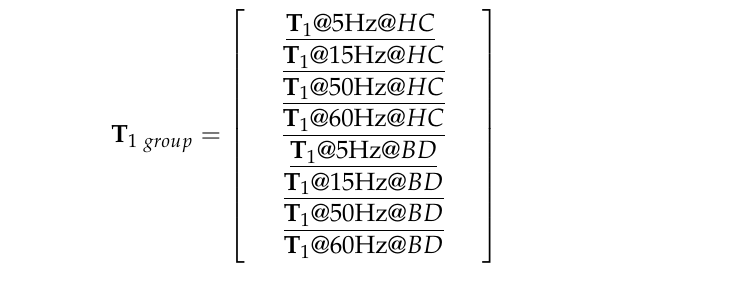
Table 3. Representation of the grouping of the feature matrices computed by means of analyzing the vibration signals in TD, FD and TFD for each supply frequency for the considered bearing conditions; where the notations HC and BD represent the healthy condition and the bearing damaged